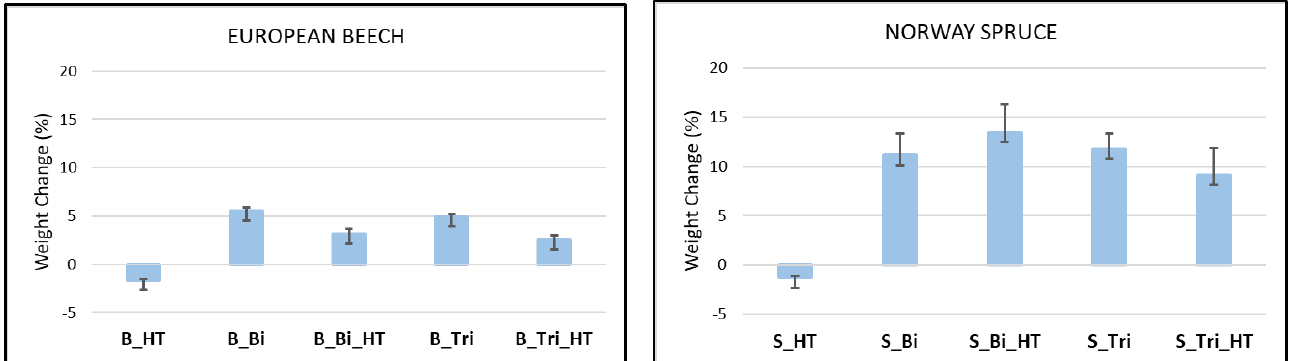
Figure 2. Weight changes as a result of treatments on beech (B) and spruce (S). Bi = bicine, Tri = tricine, HT = thermal modification.